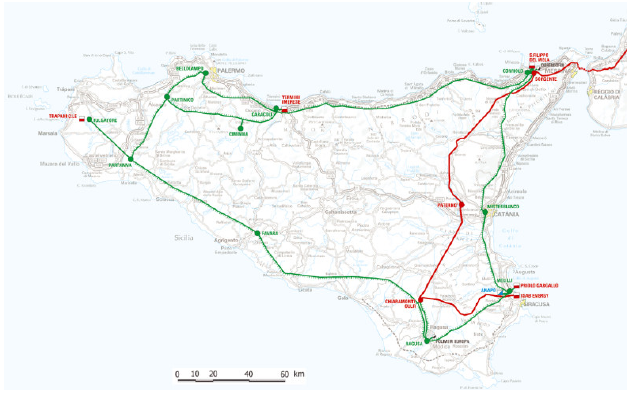
Figure 1. The studied grid